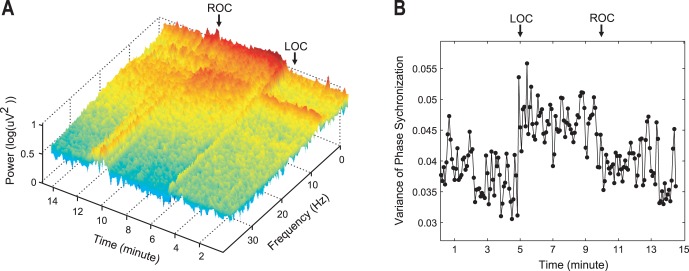
Example of changes of power spectrum and phase synchronization after anesthesia.(a) The averaged spectrogram of 21 EEG channels for a subject, and (b) the variance of phase synchronizations between 21 EEG channels for a subject during general anesthesia. This demonstrates the significant changes of the power spectrum and the variance of phase synchronization during general anesthesia. The loss of consciousness and the recovery of consciousness happen at 5 and 10 minutes.